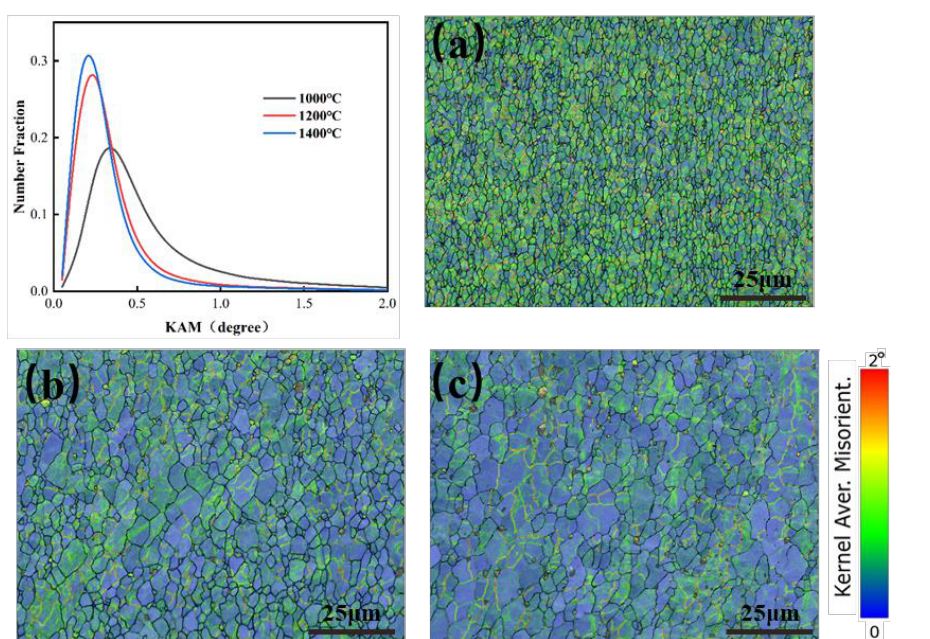
Figure 21. KAM maps for Mo − 1.5wt%ZrO 2 molybdenum alloy at strain rate of 0.1 s −1 : ( a ) 1000 °C, ( b ) 1200 °C, ( c ) 1400 °C.